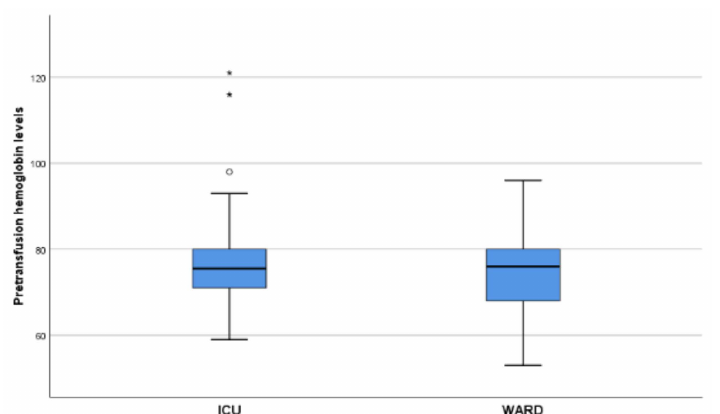
Figure 1. The mean hemoglobin level (Hgb) at transfusion was 75 g/L (range 59–121g/L) in the ICU (NRBC = 139) and 77 g/L (range 53–96 g/L) in other wards (NRBC = 165). NRBC: number of red blood cell